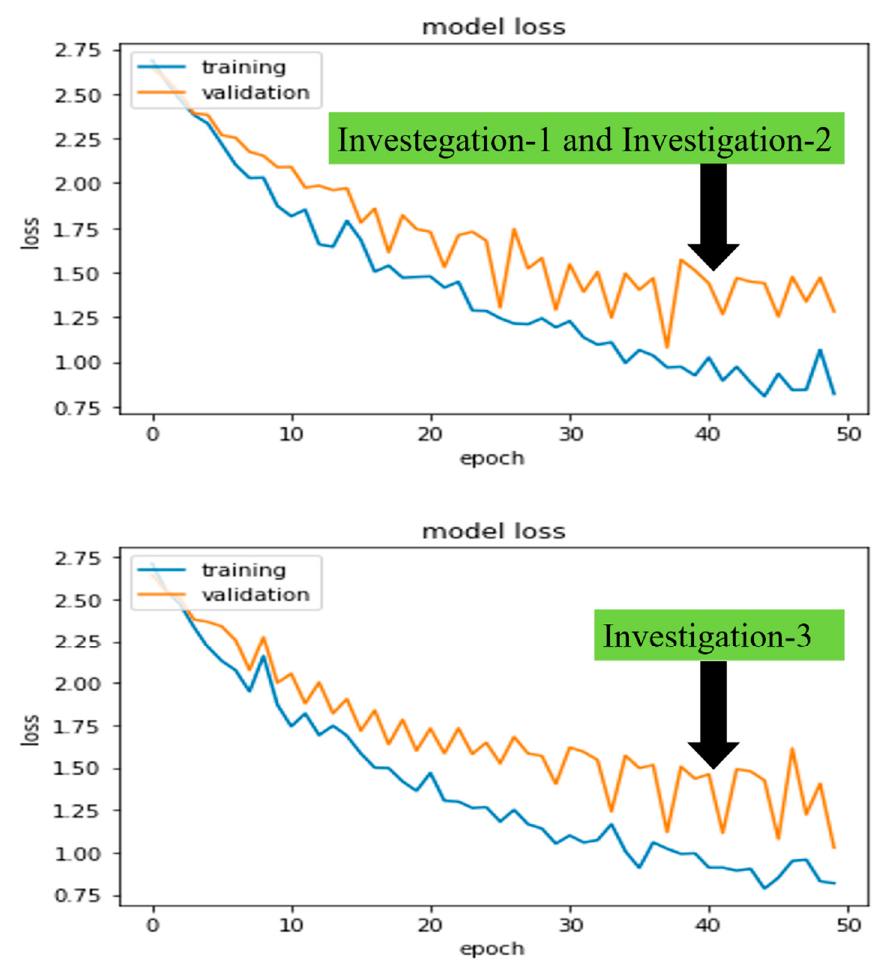
Figure 8. The CheXNet model’s training and validation losses in investigation-1 and 2 ( top ) and investigation-3 (bottom) per epoch.